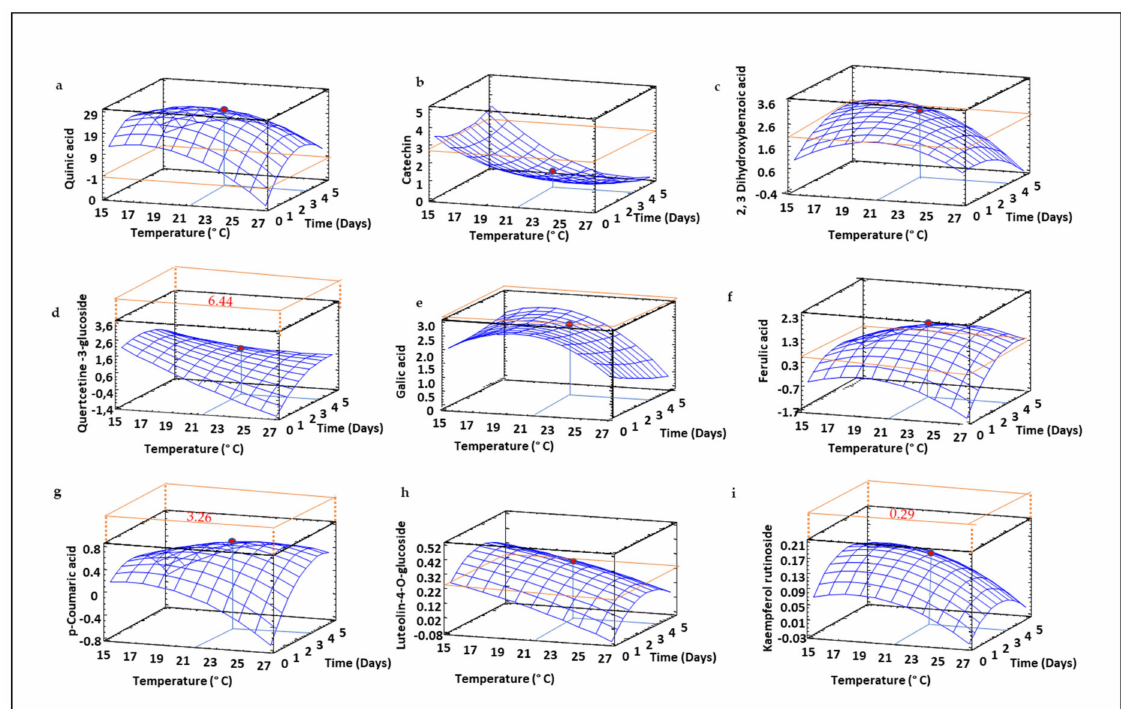
Figure 7. Three-dimensional response surface plots for the content ( µ g mg − 1 ) of insoluble phenolic compounds determined using High-performance liquid chromatography (HPLC) coupled to a tandem quadrupole mass spectrometer: Quinic acid ( a ), Catechin ( b ), 2,3, Dihydrobenzoic acid ( c ), Quertcetin-3-glucoside ( d ), Gallic acid ( e ), Ferulic acid ( f ), p-Coumaric acid ( g ), Luteolin-4-O-glucoside ( h ), and Kaempferol rutinoside ( i ) as a function of the interaction between germination temperature and time. The red line corresponds with the control (ungerminated seed) and the red point with the value for optimum conditions (21 ◦ C and 3.5 days).